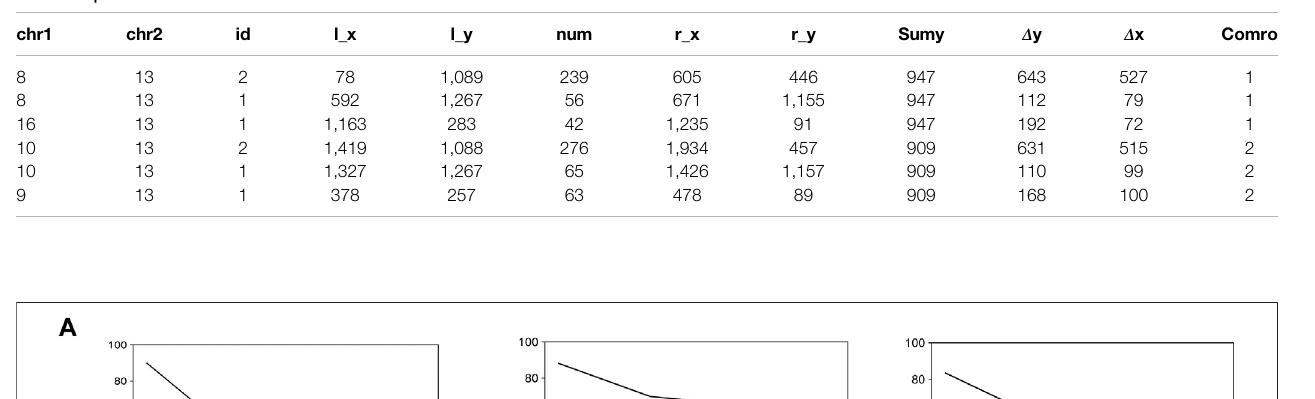
Frontiers in Genetics |